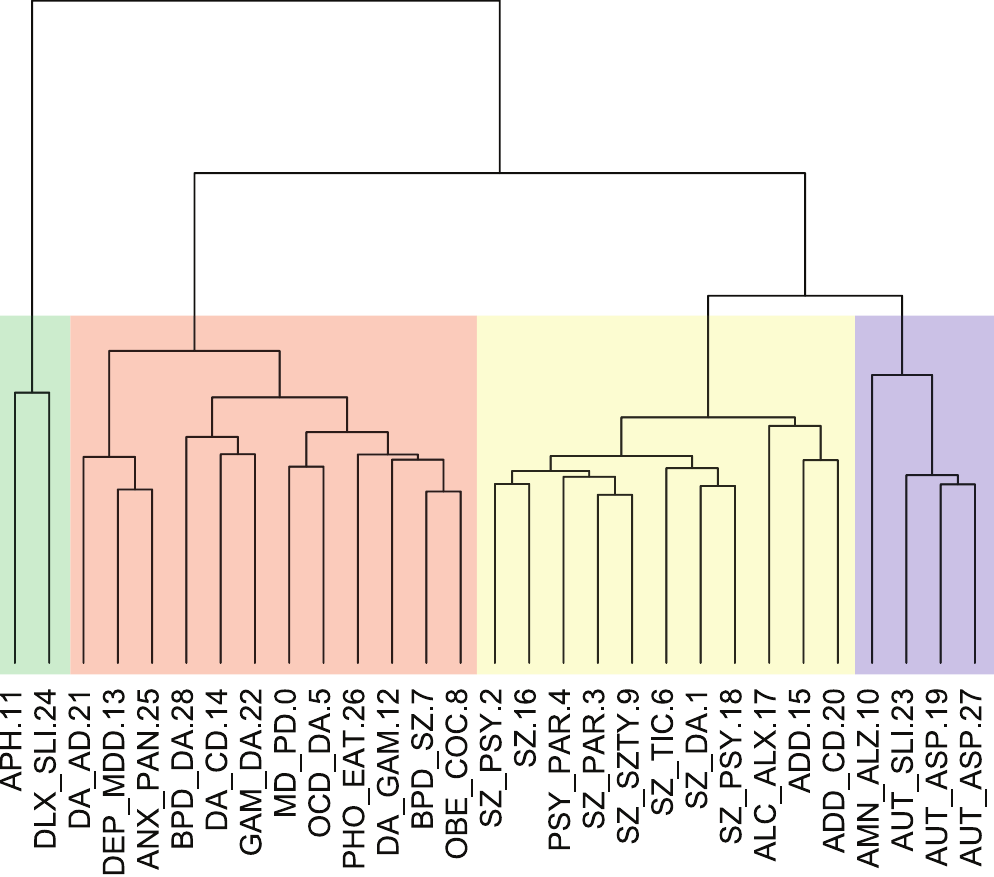
Figure 7. A clustering denodrogram showing the relationships between the different disorder topics based on their distance in neural activation space. Euclidean distance was used as the distance metric for clustering, and hierarchical clustering was performed using Ward’s method. The colored blocks show the four major groupings obtained by cutting the tree at a height of 2.0. Abbreviations: APH: aphasia, DLX:dyslexia, SLI: specific language impairment, DA: drug abuse, AD:Alzheimer’s disease, DEP:depressive disorder, MDD:major depressive disorder, ANX:anxiety disorder, PAN: panic disorder, BPD: bipolar disorder, CD: conduct disorder, GAM: gambling, MD: mood disorder, PD: Parkinson’s disease, OCD: obsessive compulsive disorder, PHO: phobia, EAT: eating disorder, SZ: schizophrenia, OBE: obesity, COC: cocaine related disorder, PSY: psychotic disorder, PAR: paranoid disorder, SZTY: schizotypal personality disorder, TIC: tic disorder, ALC: alcoholism, ALX: alexia, ADD: attention deficit disorder, AMN: amnesia, AUT: autism, ASP: Asperger